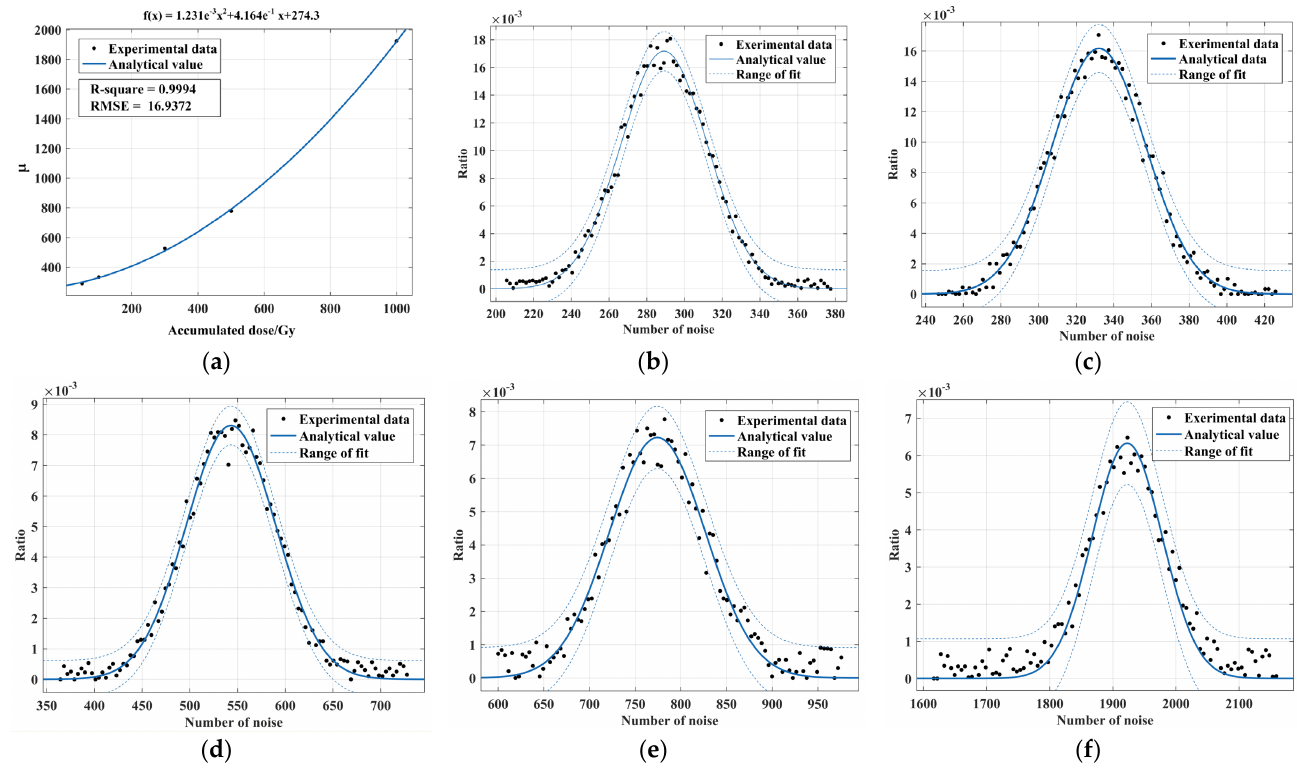
Figure 6. The number of noise distributions for ( a ) Different accumulated doses; ( b ) 50 Gy; ( c ) 100 Gy; ( d ) 300 Gy; ( e ) 500 Gy; and ( f ) 1000 Gy. Table 3. One-dimensional single Gaussian fitting noise number distribution parameters.